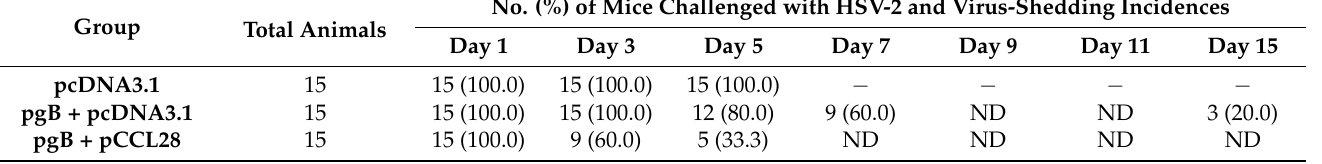
Figure 6. Virus shedding and latent viral DNA of immunized mice post challenge. On day 49 post boost, mice ( n = 5/group) were challenged i.vag. with a lethal dose of HSV-2 (2.4 × 10 7 PFU/mL). ( A ) Virus shedding in the vaginal fluids was determined by plaque assay at the indicated time points. The dashed line indicates the detection limit of the virus. ( B ) Latent viral DNA loads. The viral DNA in sacral ganglia samples was quantified by quantitative real-time PCR (qPCR) on day 30 post challenge or the day of death. Data are expressed as the means ± SEMs pooled from at least three independent experiments, with each condition performed in duplicate. Number × ND, means the number of mice in which latent virus cannot be detected; *** p < 0.001; antigen group compared to Table 1. Incidences of virus shedding in mice post HSV-2 challenge (%) *. No. (%) of Mice Challenged with HSV-2 and Virus-Shedding